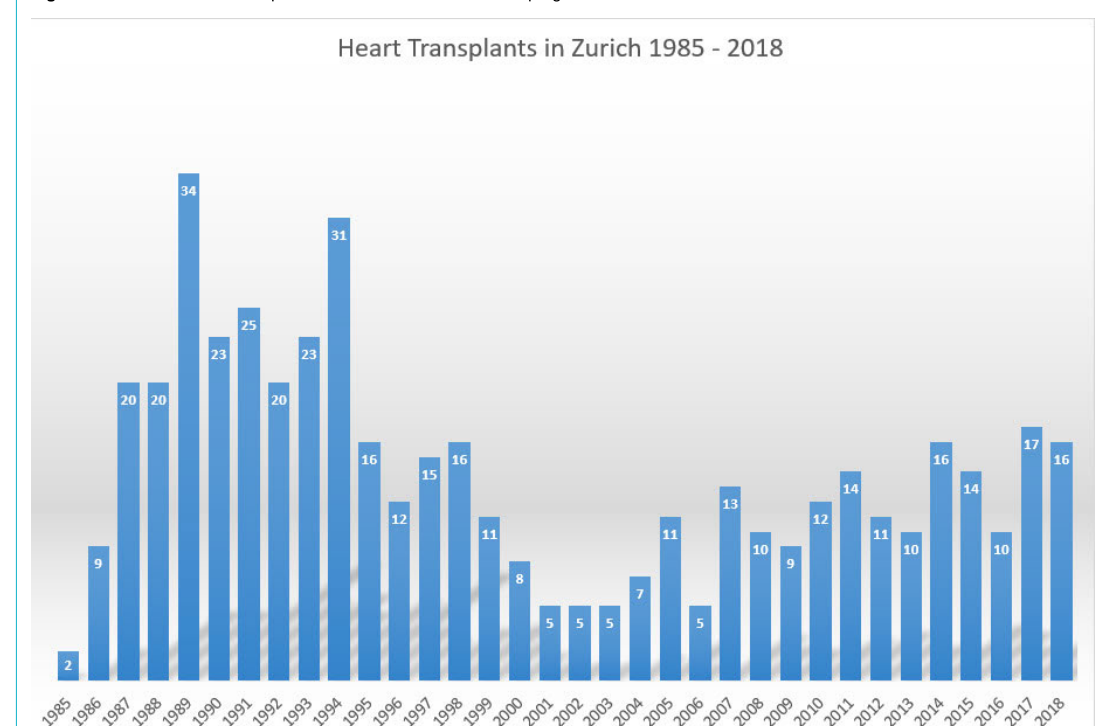
Figure 2: Number of heart transplants in Zurich from restart of the programme in 1985 until